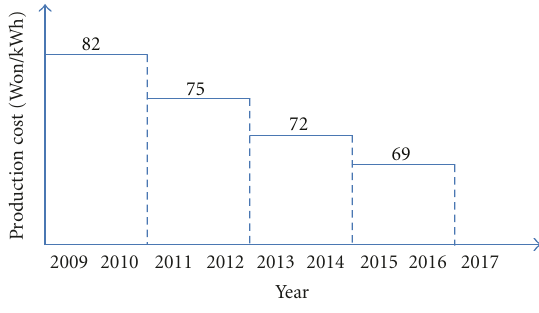
Figure 21: Expected production costs of wind energy.